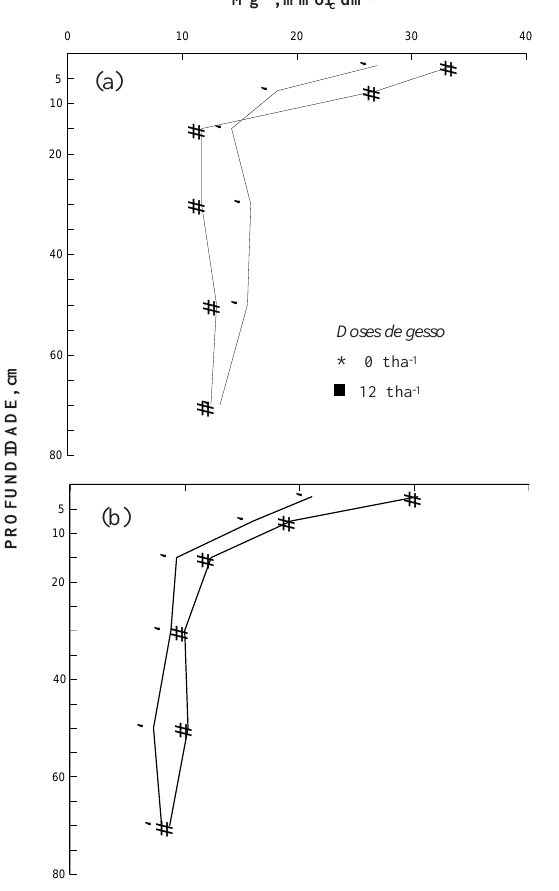
Figura 5. Efeito de doses de gesso sobre o teor de Mg trocável no solo após 14(a) e 36(b) meses de sua aplicação, na dose de 6 t ha -1 de calcário.